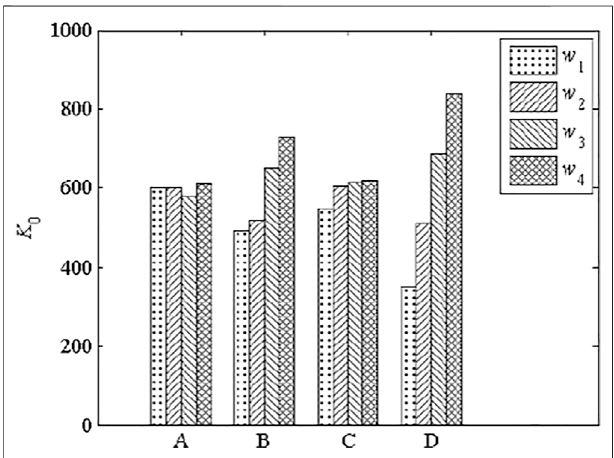
FIGURE 14 | In fl uence of the four factors on initial shear